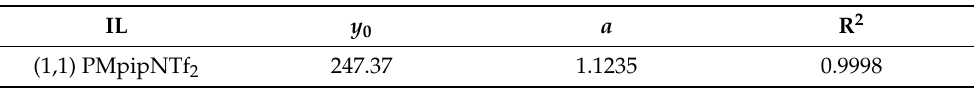
Figure 2. Experimental molar heat capacities, Cp, as a function of temperature for the (1,1) PMpipNTf 2 , solid lines represent the fitting using Equation (1). Table 2. Fitting parameters for the fitting (Cp = y 0 + a T) of the experimental molar heat capacities for PMpipNTf 2 ionic liquid.